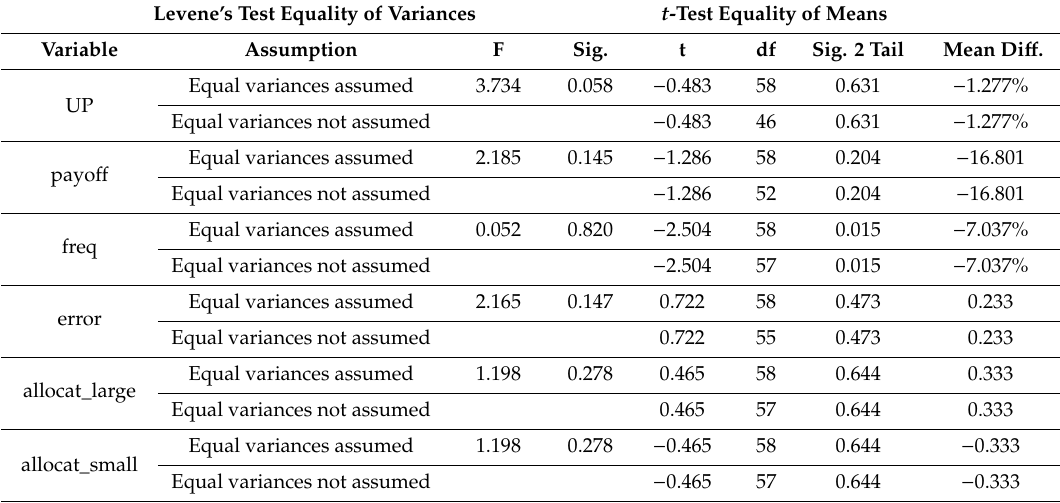
Table 7. Levene’s test for the equality of variances and the t -test for the equality of the means of the outcomes of the auction with a discount of 8% and